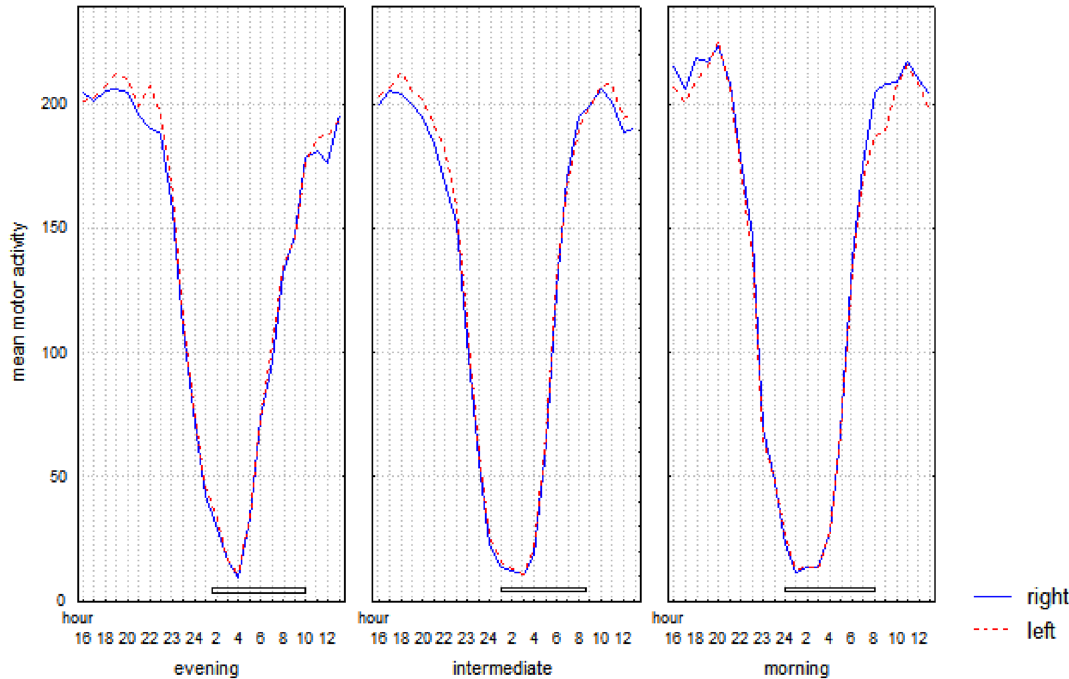
Figure 1. Hourly mean motor activity over the 24 h of the right and left hand in evening, intermediate, and morning types. The white horizontal bar represents the time spent in bed by each chronotype, with the extremes pointing to the bedtime and get-up